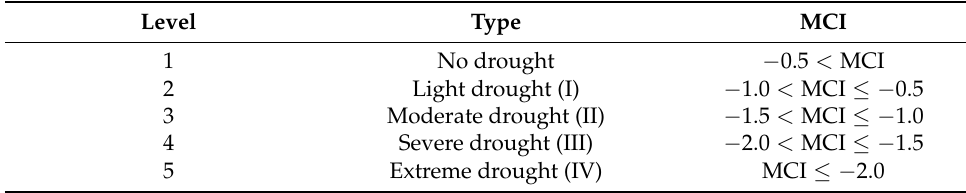
Table 1. Different MCIs and their corresponding drought level